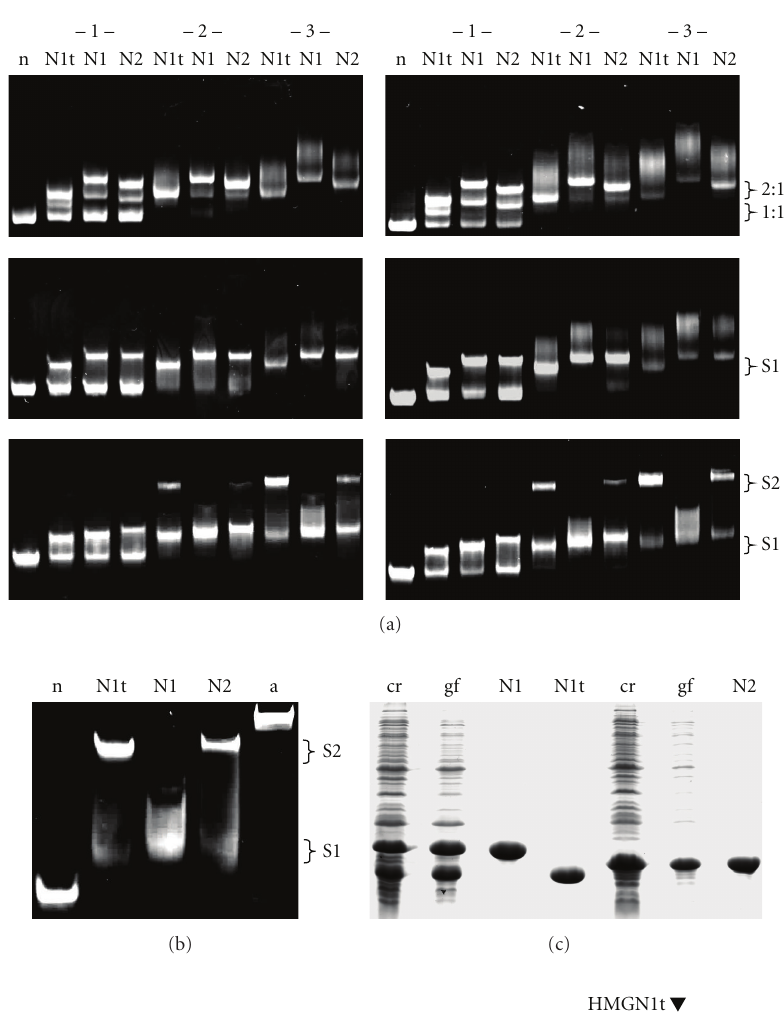
Figure 1: HMGN binding to the nucleosome core is ion dependent and capable of eliciting a transition. Gel labels indicate HMGN identity (N1t, HMGN1t; N1, HMGN1; N2, HMGN2; n, NCP alone; a, nucleosome array alone), and numbers designate HMGN:nucleosome molar stoichiometry. (a) EMSAs of HMGN binding to two distinct NCP constructs, NCP-601 (left) and NCP147 (right), under three di ff erent bu ff er conditions: low ionic strength (top), near physiological ionic strength (middle), and near physiological ionic strength with 1mM Mg 2+ (bottom). Under noncooperative binding conditions (top), 1:1 as well as 2 :1 HMGN :nucleosome species are observed at low stoichiometry [12]. At higher ionic strength (middle), 2:1 species (S1) are the only specific complexes that occur. In the presence of divalent metal, a distinct, slow-migrating species (S2) is also observed for HMGN1t and HMGN2 binding. (b) EMSA showing migration rate for S1 and S2 of NCP-601 (HMGN:nucleosome = 4:1) relative to NCP and a 4-nucleosome array. (c) SDS-polyacrylamide gel analysis of HMGN purification products (see Methods). Samples from HMGN1 (left) and HMGN2 (right) overexpression are shown for crude extract (cr) and after gel filtration (gf) and ion-exchange chromatography (N1, N1t, and N2). (d) Xenopus HMGN primary structures. Functional domains are the NBD (blue) and RD (red). Nuclear localization elements are shown in green.